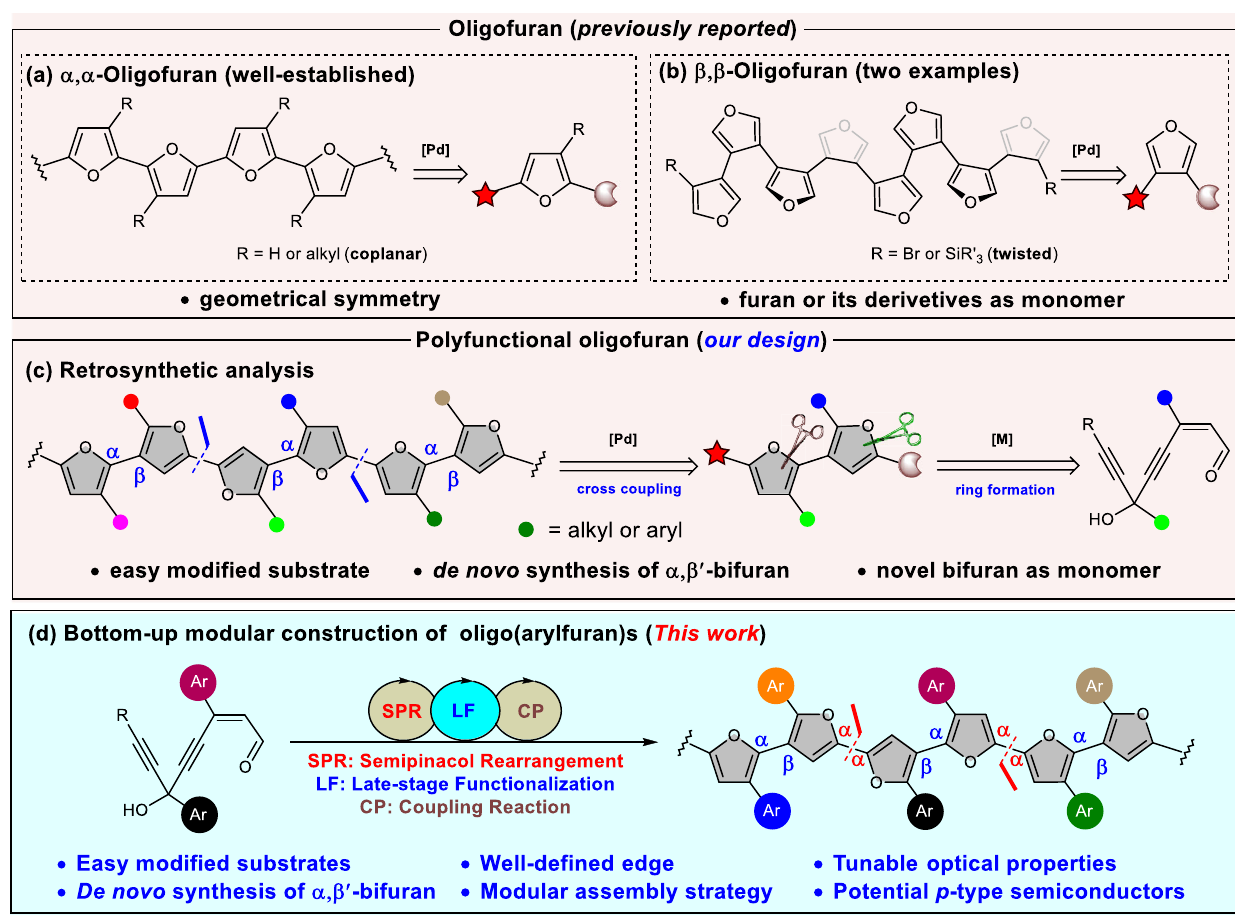
Fig. 1 Development of oligofurans. a α , α -Oligofurans. b β , β -Oligofurans. c Retrosynthetic analysis of polyfunctional oligofuran. d This work: bottom-up modular synthesis of